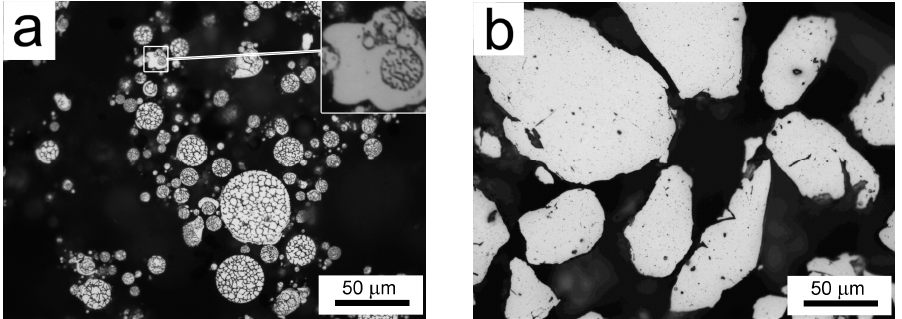
Figure 2. The morphology of ( a ) Al7075Zr_A and ( b ) Al7075Zr_M powder particles, light microscopy (LM).